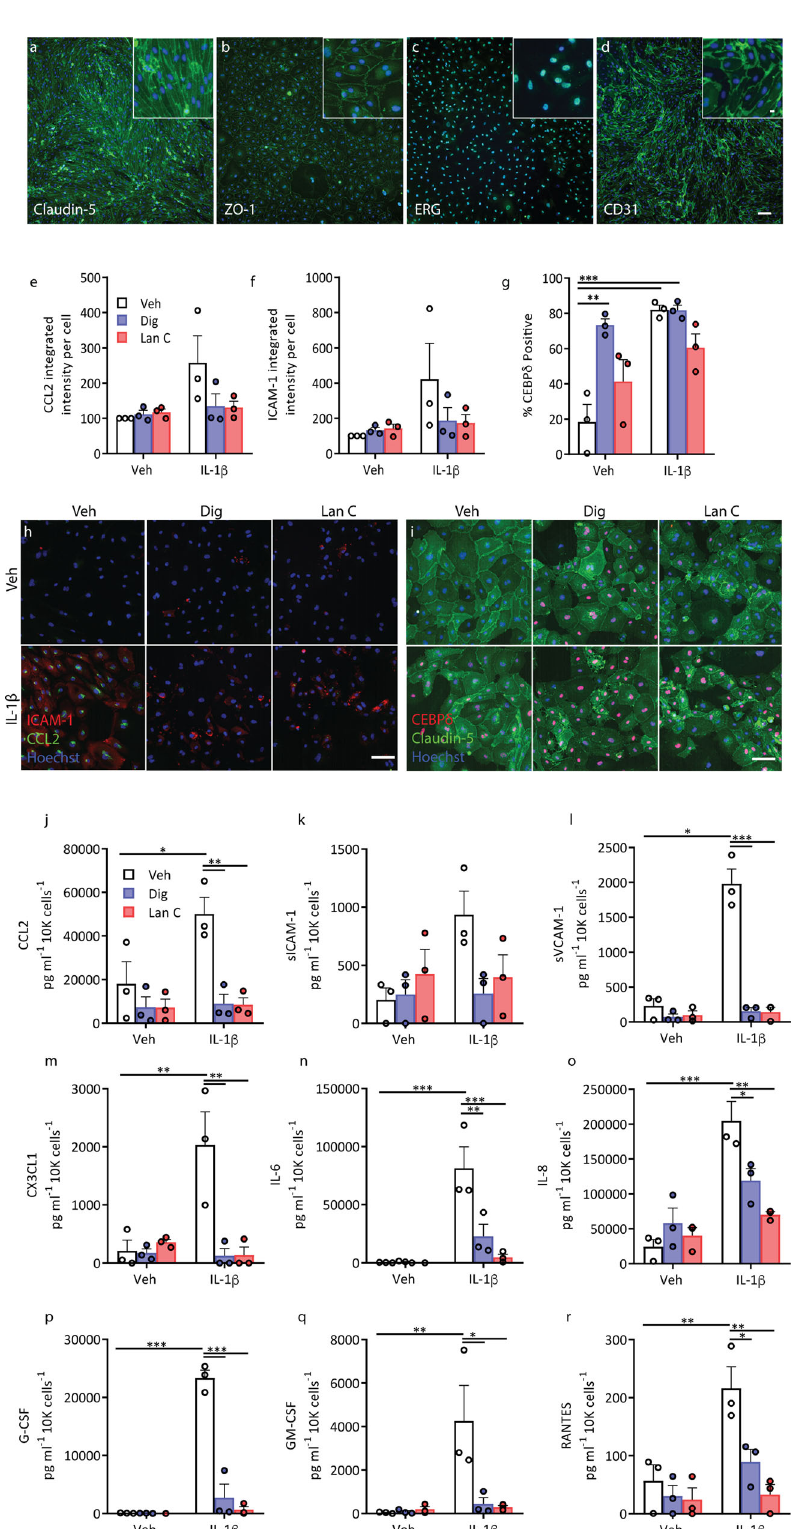
Fig. 4 In fl ammatory cytokine secretion is blocked by both digoxin and lanatoside C in primary human brain endothelial cells. Endothelial cells derived from human brain tissue express endothelial markers, Claudin-5 ( a ), ZO-1, ( b ), ERG ( c ) and CD31 ( d ). e – g Human endothelial cells were pretreated with vehicle (white bars), digoxin (100 nM, blue bars) or lanatoside C (1 µ M, red bars) for 24 h, followed by 24h of IL-1 β (0.05 ng mL − 1 ) treatment. Staining quanti fi cation of CCL2 ( e ), ICAM-1 ( f ) and nuclear CEBP δ ( g ), in endothelial cells ( n = 3, cases used: SS42, SS50, E214). Representative images ( h , i ). j – r Conditioned media was analysed by CBA in endothelial cells treated as above ( n = 3, cases used: SS42, SS50, E214). Cytokine/chemokine concentration was normalised to total cell counts (Hoechst)). Two-way ANOVA with Tukey ’ s multiple comparison test mean ± SEM. *** p < 0.001, ** p < 0.01, * p <